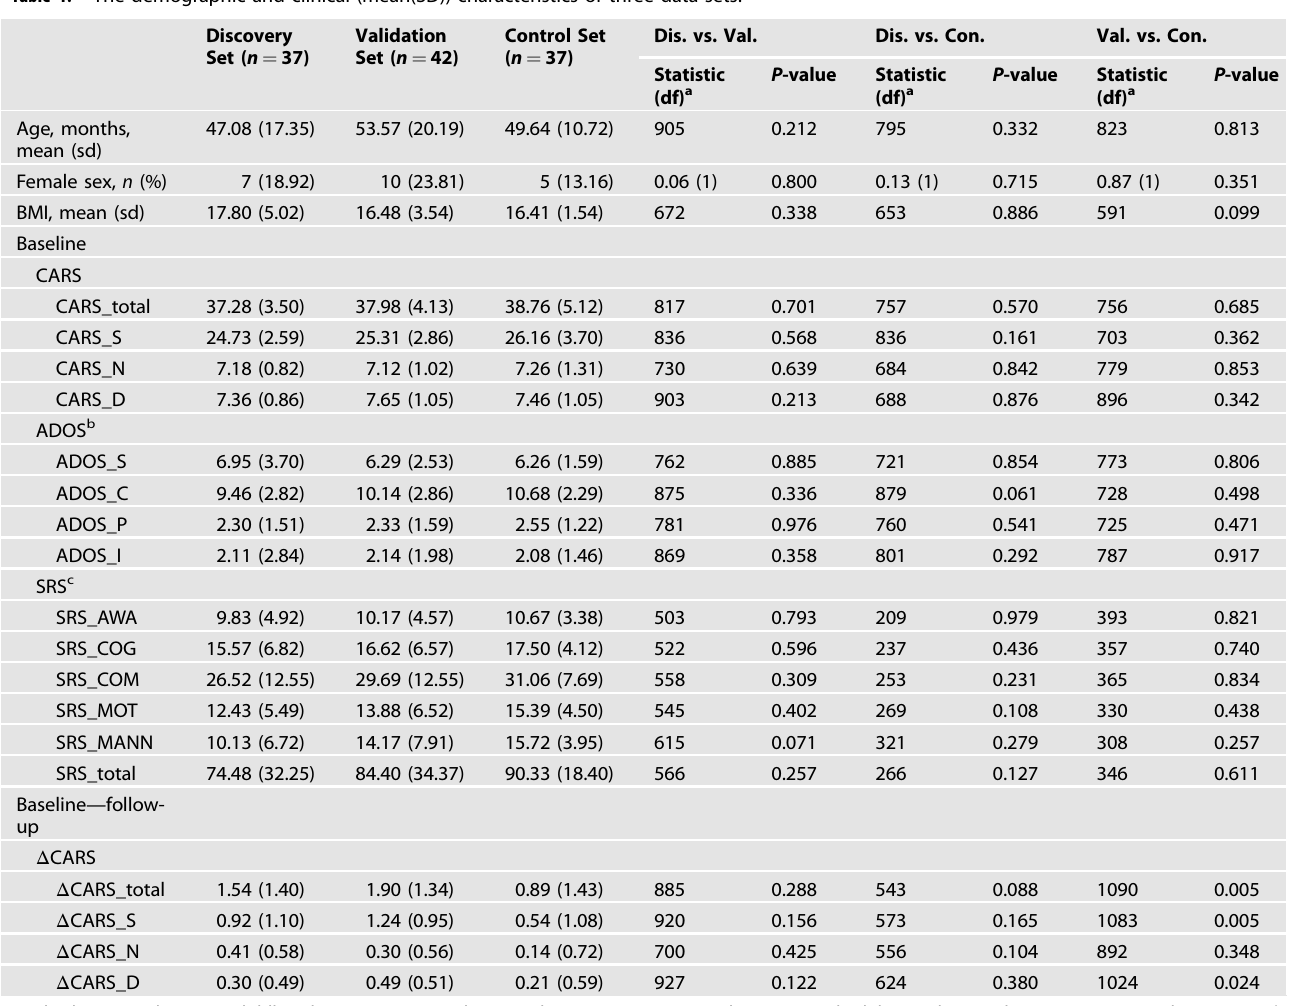
Table 1. The demographic and clinical (mean(SD)) characteristics of three data